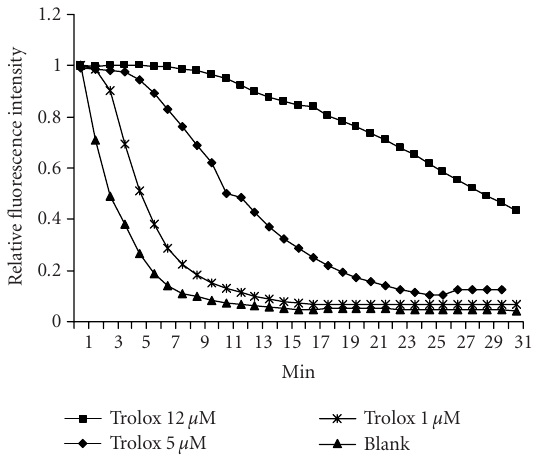
Figure 1. Trolox concentration e ff ect on FL fluorescence decay curve. Data is pooled from two